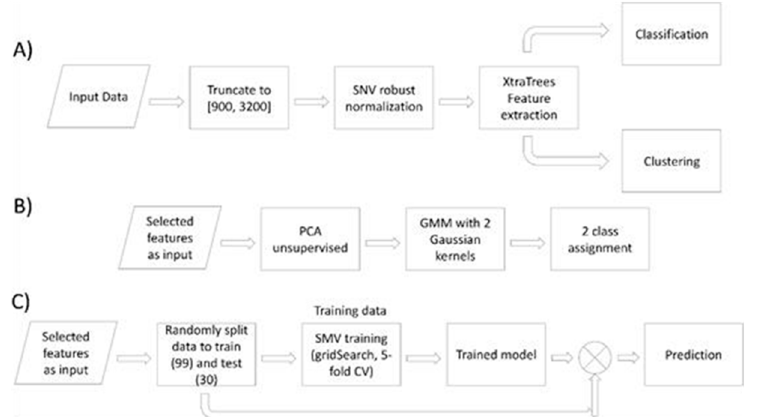
Figure 2. Overview of the data analysis and exploration. ( A ) Data manipulation steps towards classification and clustering. ( B ) Clustering workflow, natural clusters identification. ( C ) Classification pipeline, training and validation. SNV: standard normal variate; PCA: principal component analysis.